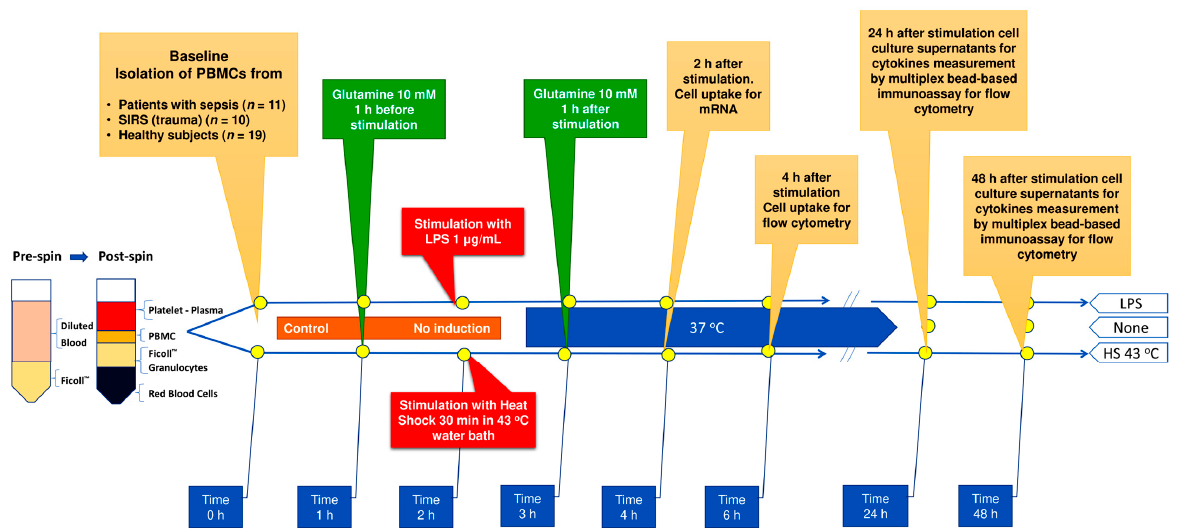
Figure 1. Experimental design. Abbreviations: PBMCs = peripheral blood mononuclear cells; SIRS = systemic inflammatory response syndrome; mRNA = messenger ribonucleic acid; LPS = lipopoly- saccharide; HS = heat shock; Pre-spin = before centrifugation; Post-spin = after centrifugation at 300 g for 30 min.